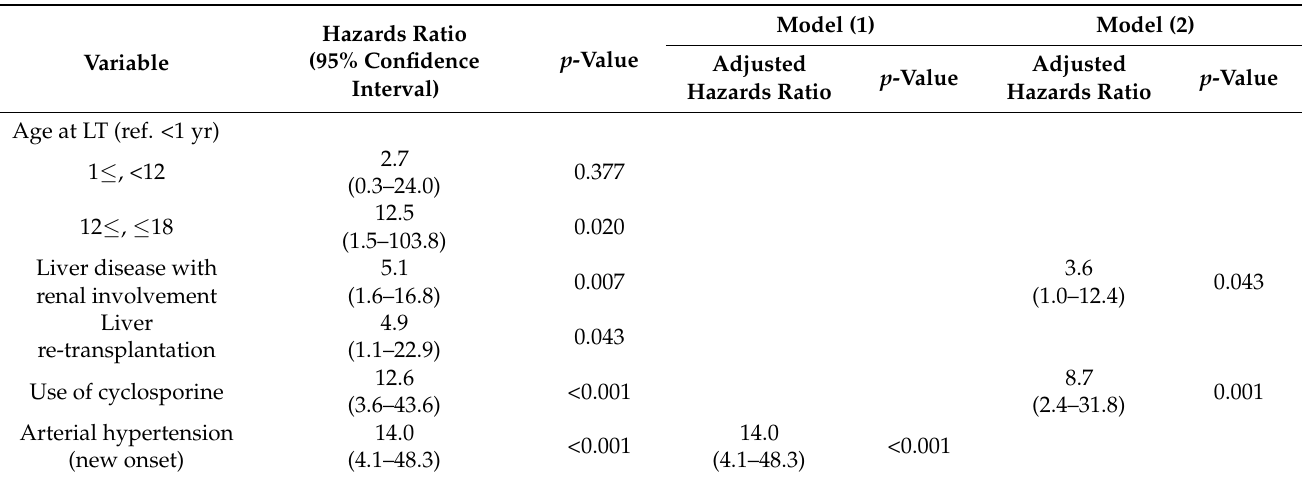
Table 3. Multivariable analysis of factors associated with stage 3 chronic kidney disease progression (n = 153).